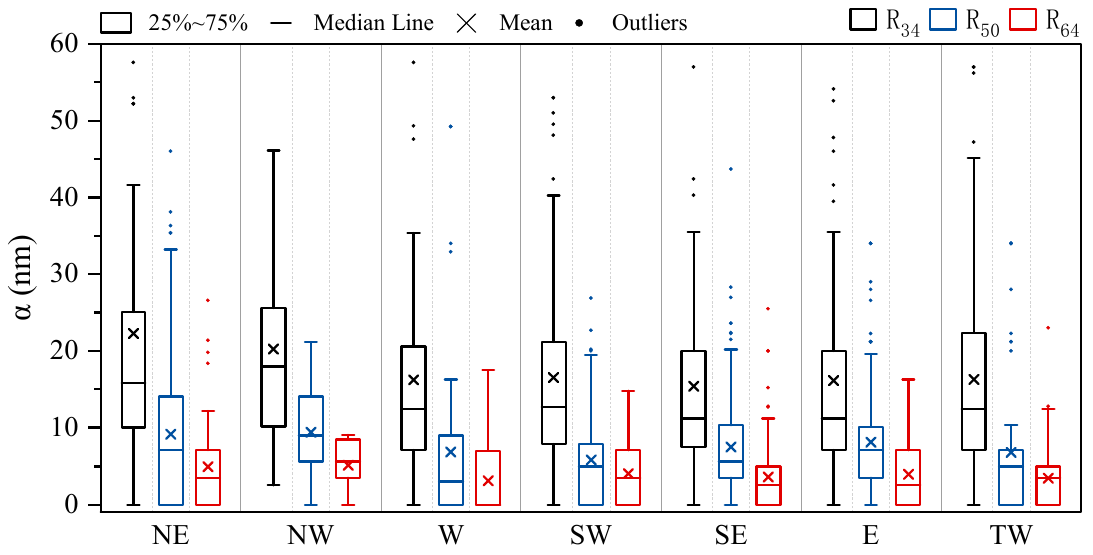
Figure 9. Box plot of the asymmetry factor α (units: nm) for R 34 (black boxes), R 50 (blue boxes), and R 64 (red boxes) in subregions near Taiwan Island.